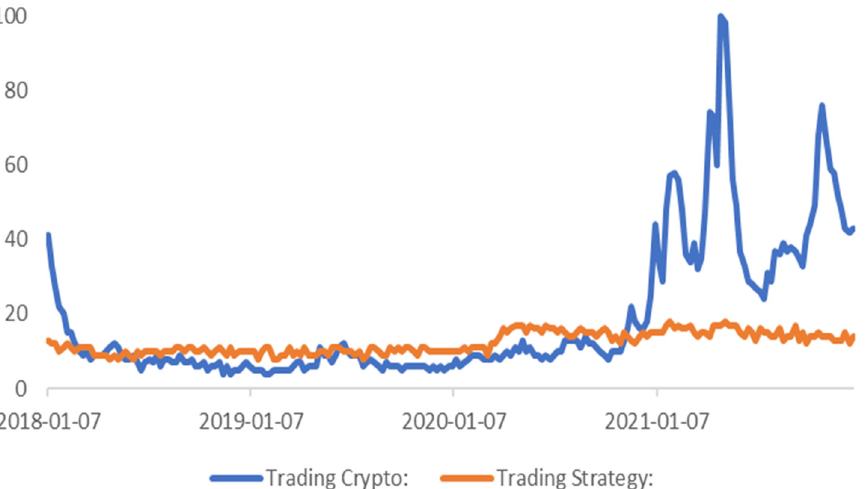
Figure 1. Google trends phrase search results for crypto trading and trading strategy in the period under the study.